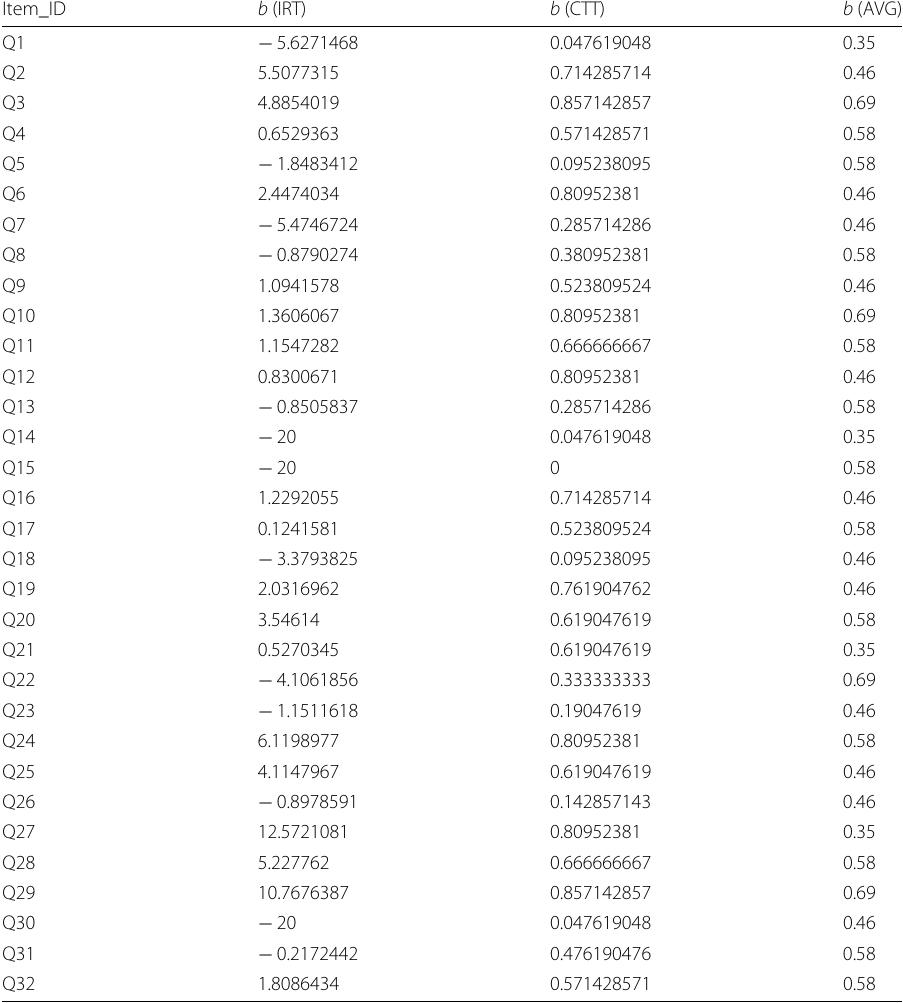
Table 8 Sample b values ( class A )